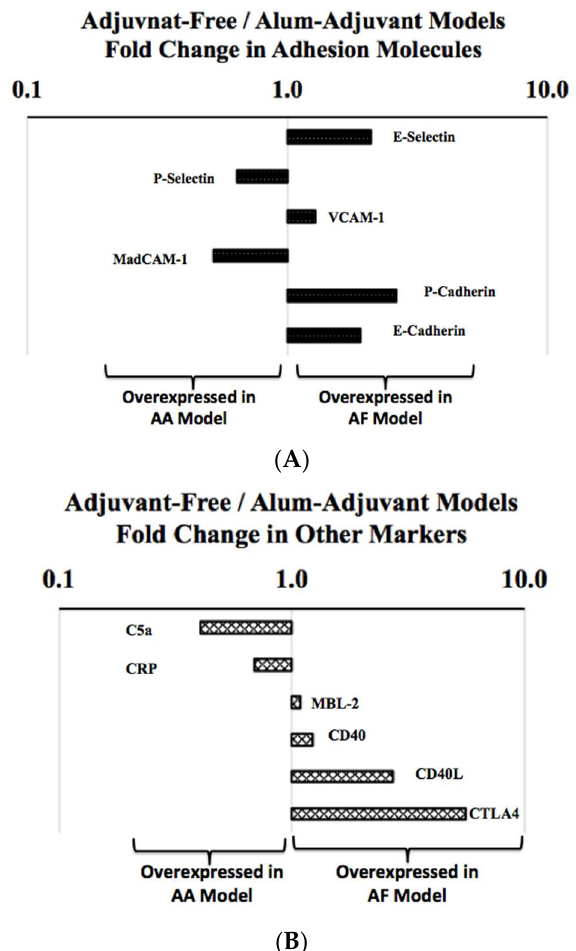
Figure 8. ( A – B ). Analysis of the in vivo activation of the adhesion molecules and other allergy-relevant immune markers in the spleen tissue of adjuvant-free vs. alum adjuvant mouse models of wheat allergy. Spleen tissues were collected from the experimental groups of mice in the AF vs. AA model, and used in the analysis of the adhesion molecules and other immune markers, as described in the methods. Using the pg/mg spleen protein content, fold changes in these markers in the AF vs. AA models were determined as shown. Data shows that the adhesion molecules (Figure A ) and other immune markers (Figure B ) are differently overexpressed in vivo in the AF vs. AA models, indicating the different mechanisms of wheat allergenicity.